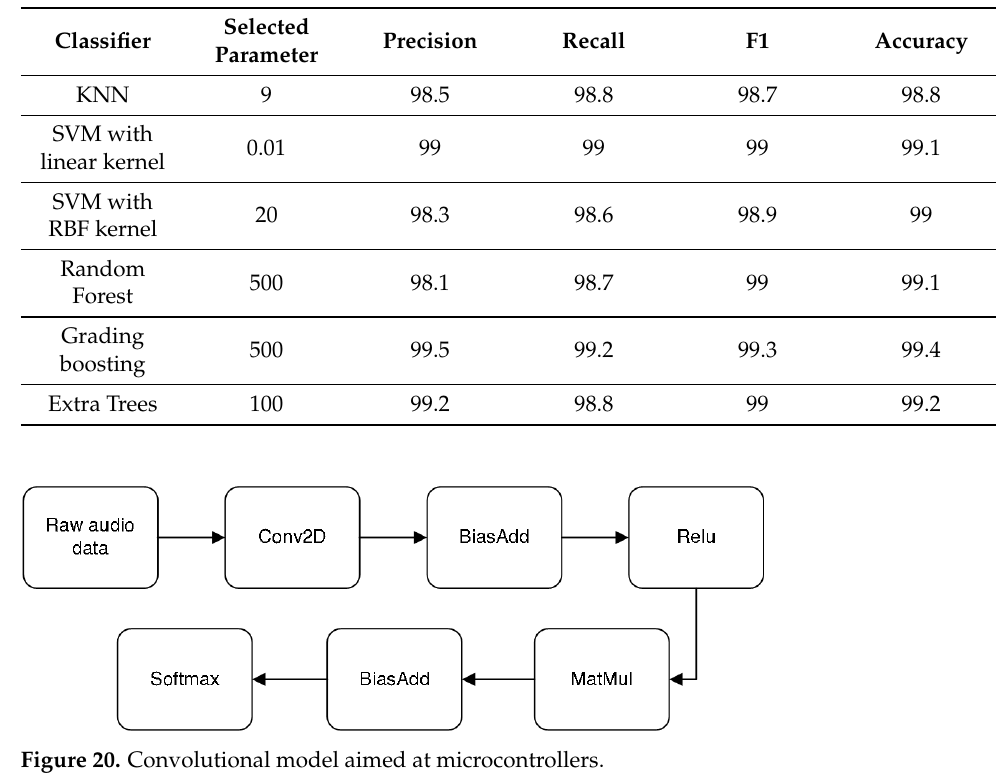
Table 8. Machine learning classifiers performance with 34 signal features extracted from audio signals with 8 kHz sampling rate. Classifiers are built for 2 classes using 20-fold stratified cross-validation.